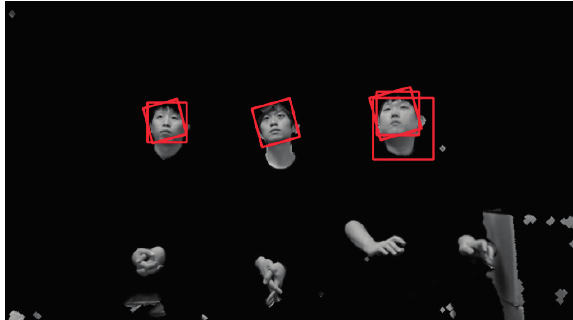
Figure 10. Results from face detection based on Figure 9 and the use of eye